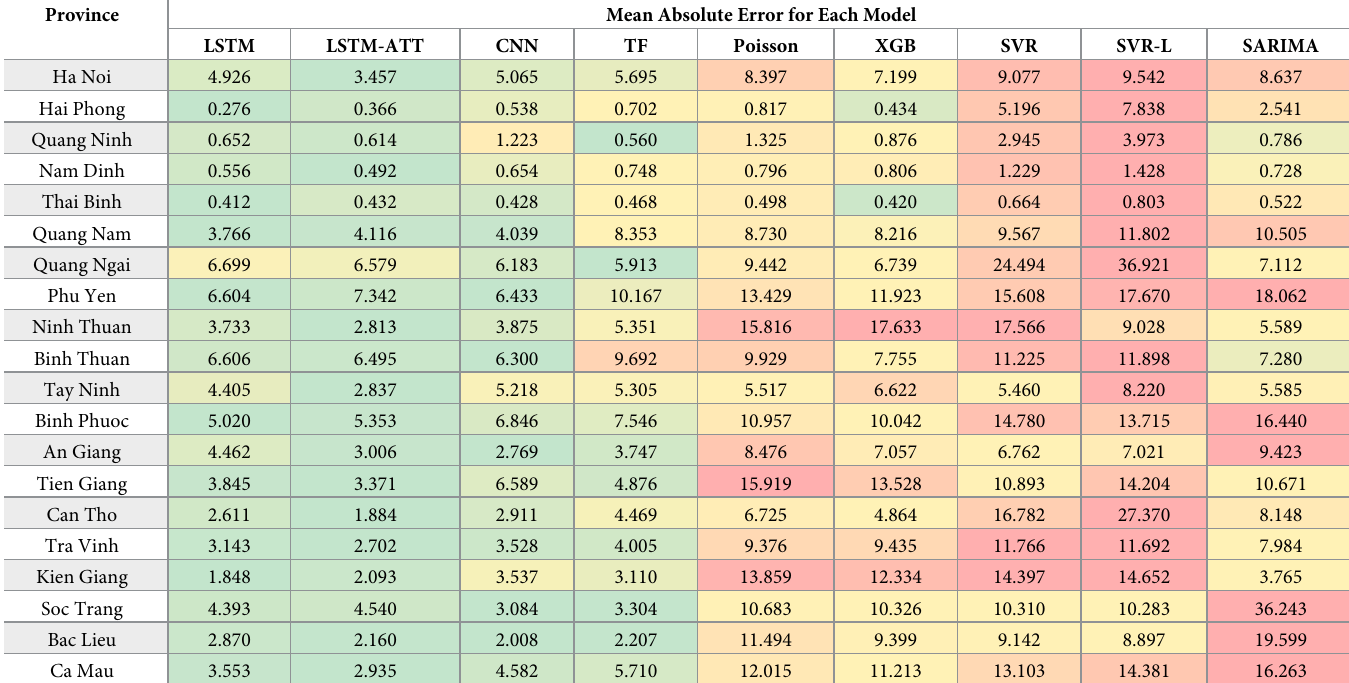
Table 3. Mean absolute errors for all prediction models in 20 Vietnamese provinces. Province Mean Absolute Error for Each Model